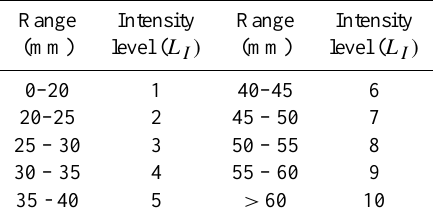
Table 5. Values ascribed for ranges of intensity in 30min (see text for